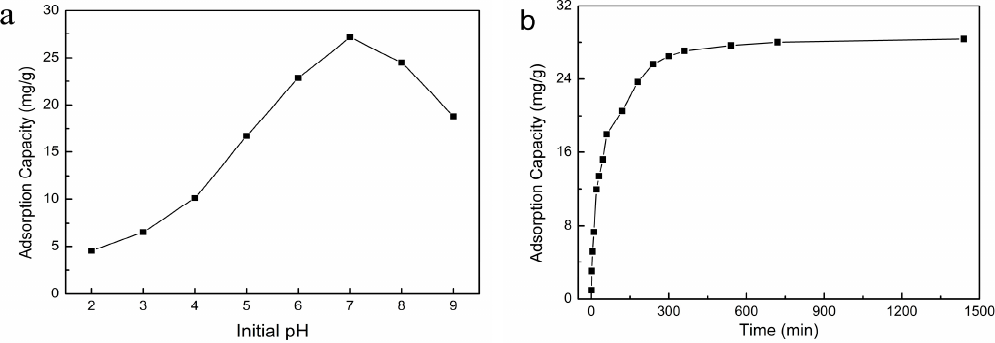
Figure 6. ( a ) Effect of the initial pH on the absorbability of SLPS for phenol and ( b ) effect of time on Figure 6. ( a ) E ff ect of the initial pH on the absorbability of SLPS for phenol and ( b ) e ff ect of time on the the absorbability of SLPS for phenol. absorbability of SLPS for